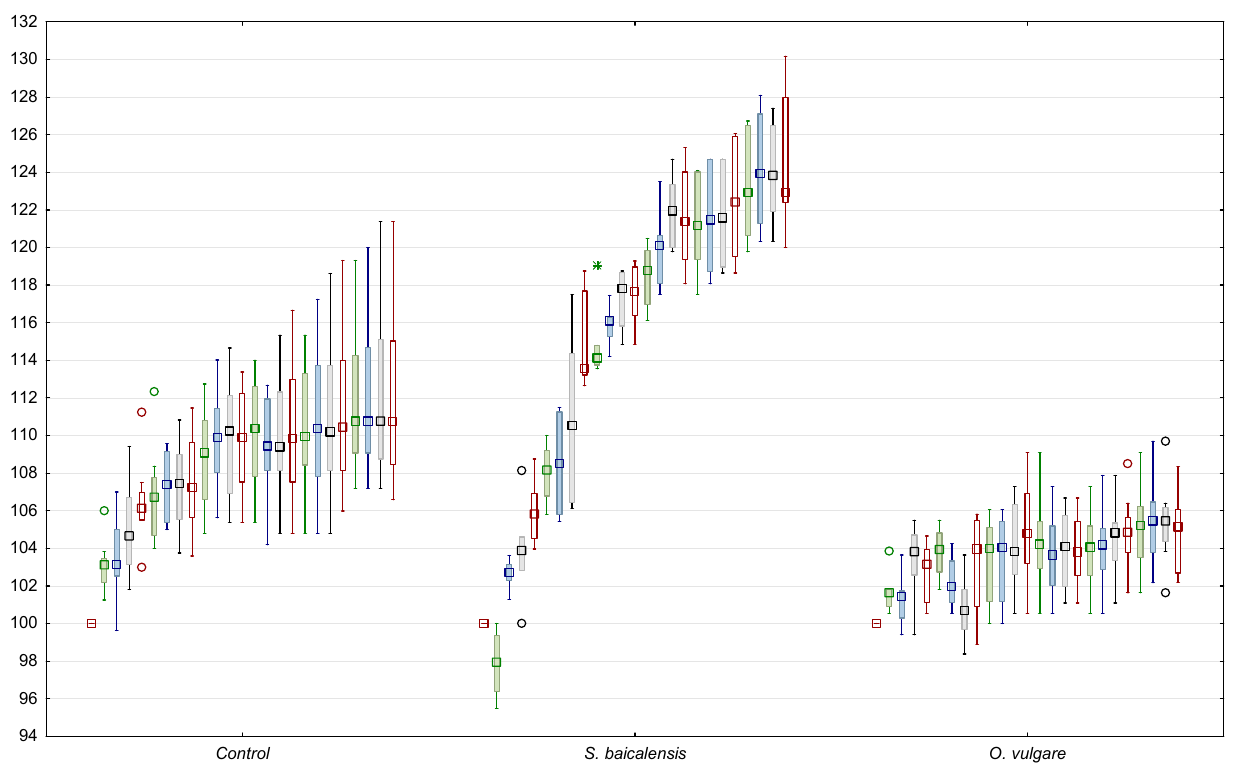
Figure 1. Changes in the body weight of rats when shredded shoots of Origanum vulgare L. and roots of Scutellaria baicalensis Georgi were added to their diet. The details are as follows: on the abscissa axis—the day of the experiment for the control, O. vulgare and S. baicalensis groups; on the ordinate axis—body weight of the animals (% relative to the baseline body weight before the start of the experiment, taken as 100% for each of the experimental animals); small square—median, the upper and lower boundary of the rectangle, being 75% and 25% of the quartile; vertical line—minimum and maximum values; circles—outliers; n = 8.